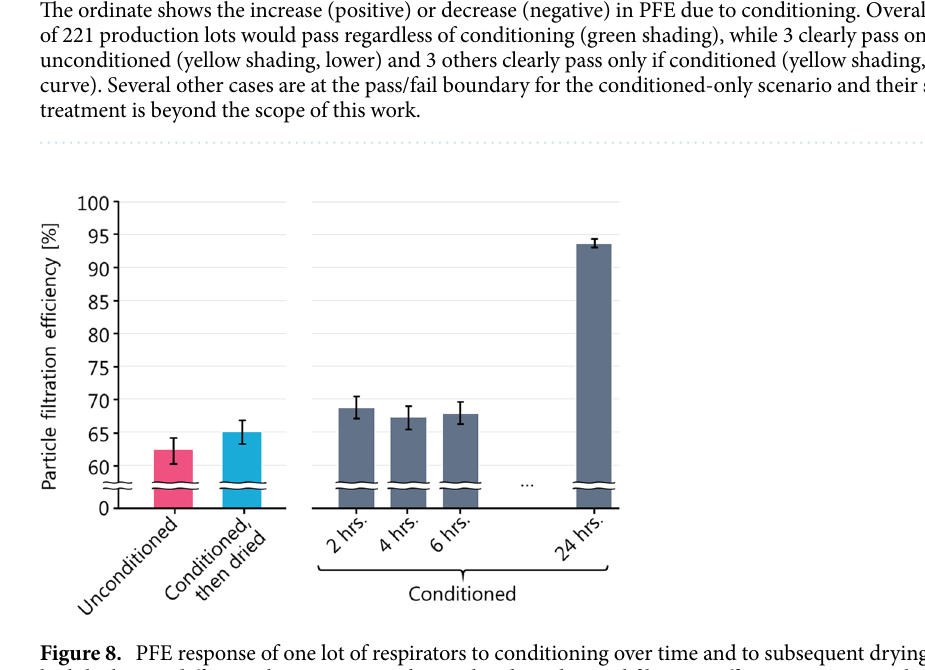
Figure 8. PFE response of one lot of respirators to conditioning over time and to subsequent drying. This lot had the largest difference between unconditioned and conditioned filtration efficiency in our 201-lot data